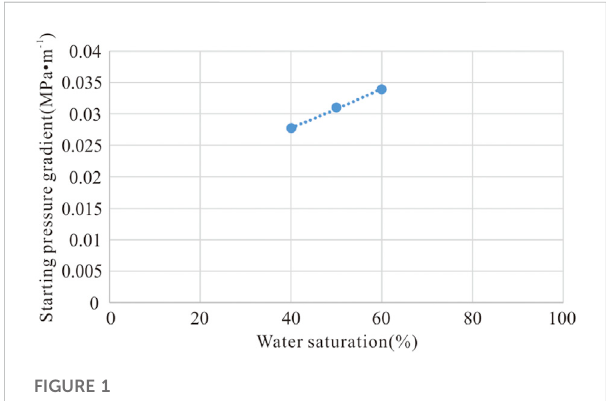
FIGURE 3 Simpli fi ed geological model of an edge-water gas